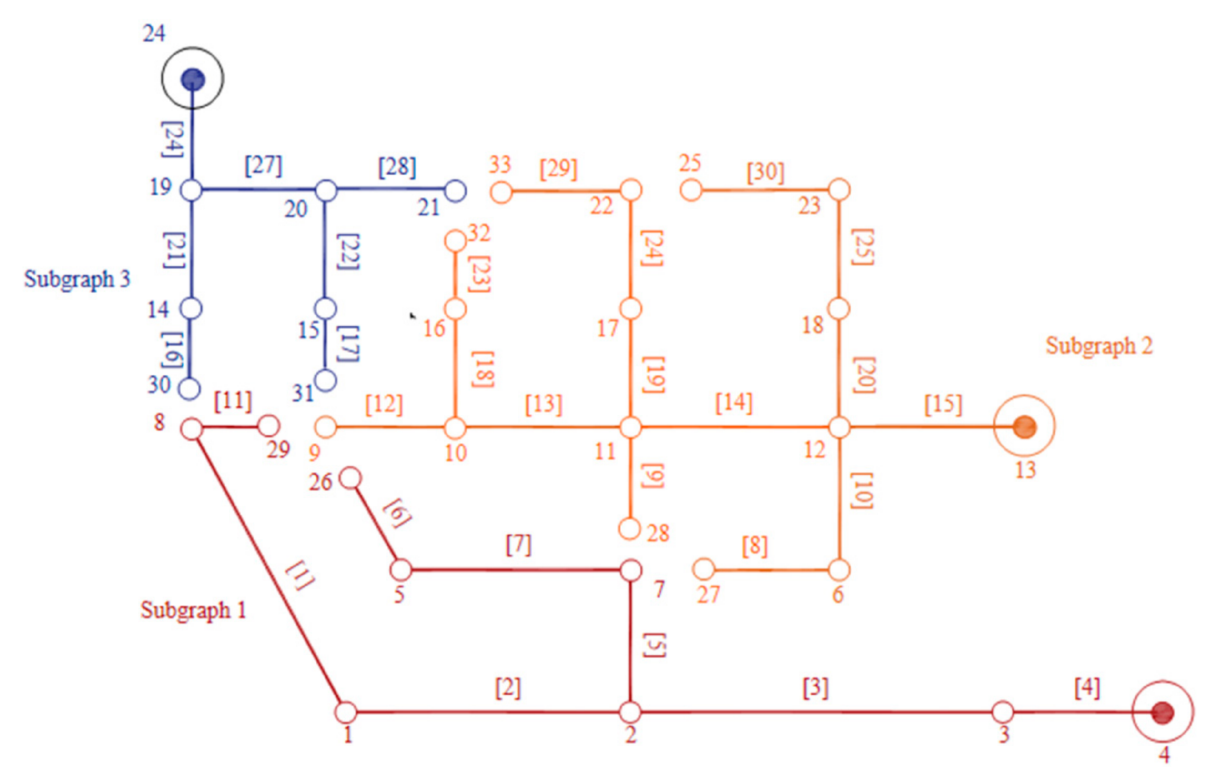
Figure 5. Generated decentralized